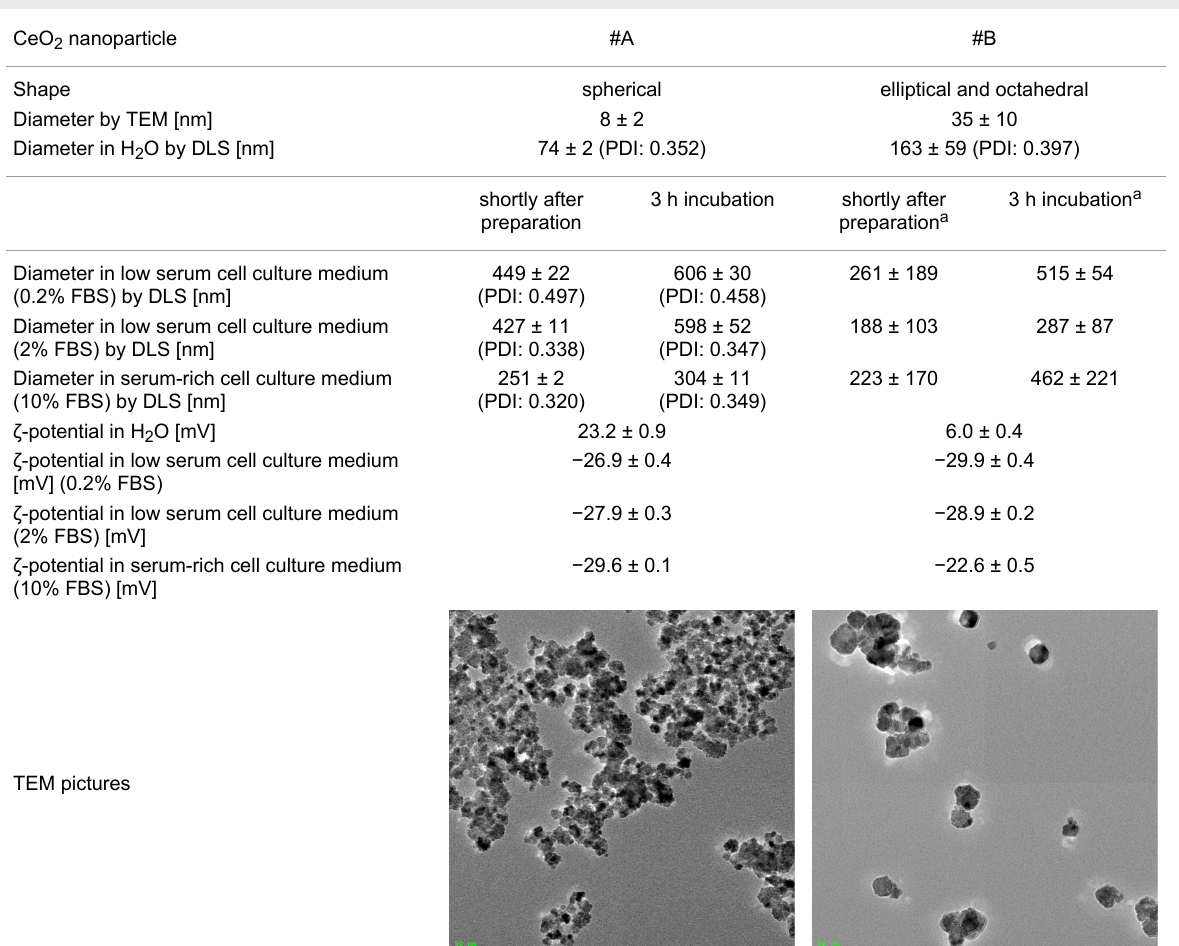
Table 1: Characterization of the CeO 2